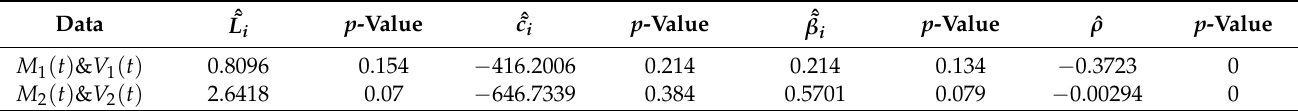
Table 6. Estimated drift group parameters (USO and